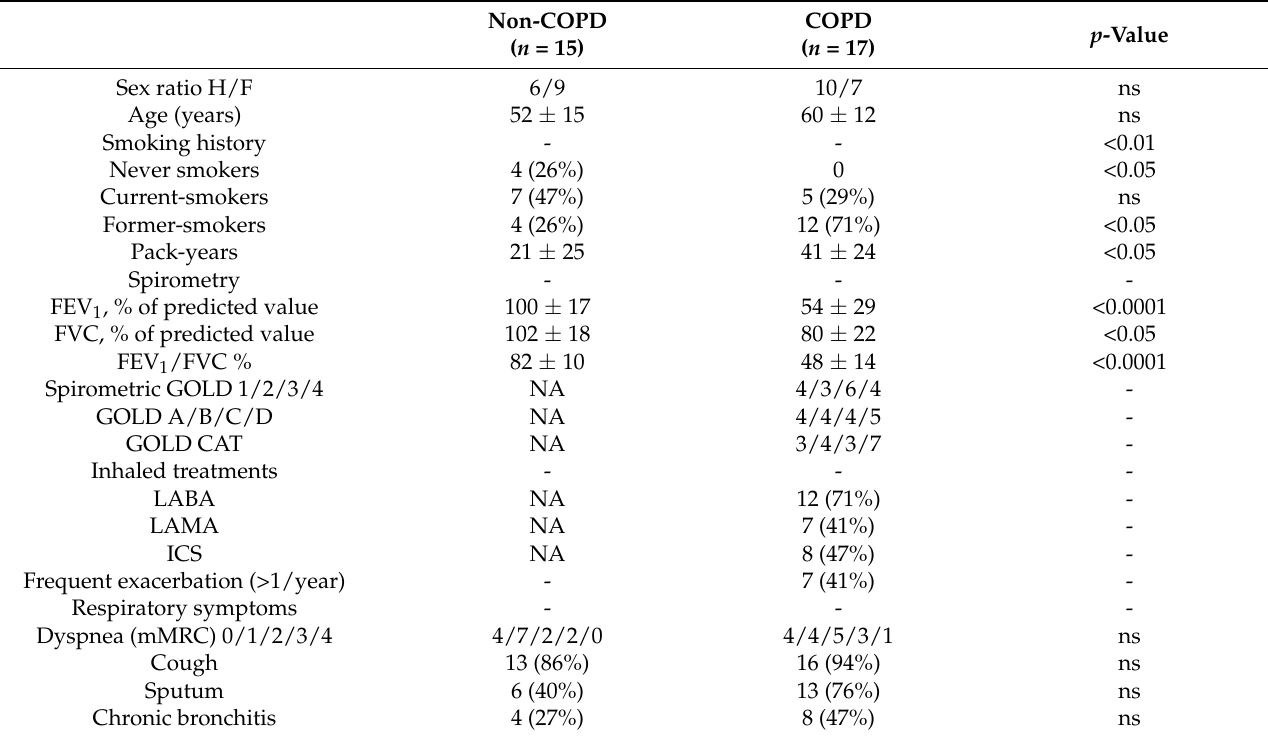
Table 1. Baseline characteristics of the